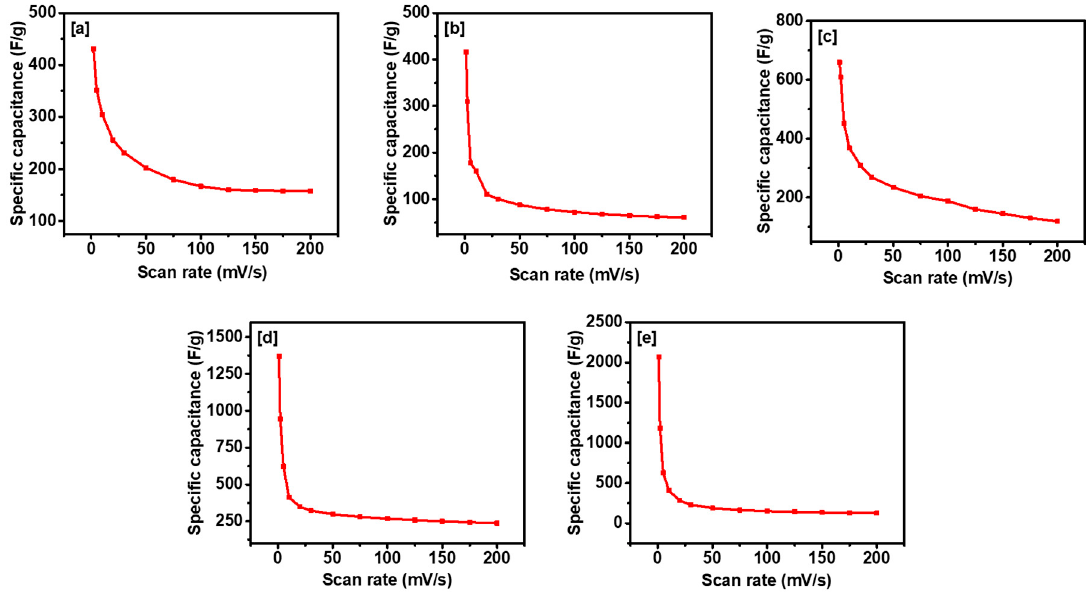
Figure 6. Variation of specific capacitance versus scan rate for ( a ) GONRs, ( b ) PPy, ( c ) 0.5 PPyGONR, ( d ) 1.5 PPyGONR, and ( e ) 3 PPyGONR.